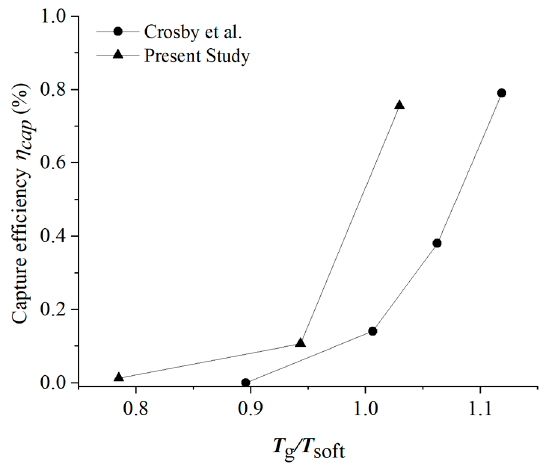
Figure 18. Comparison of the capture efficiency between present study and Crosby et al.’s [11].